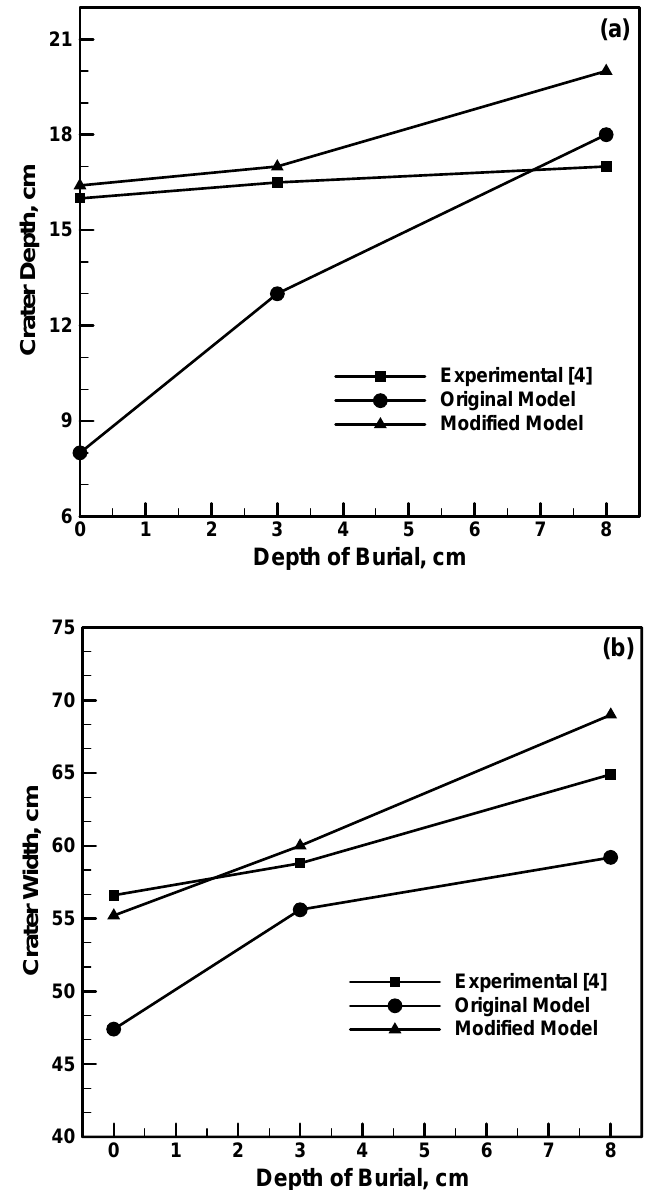
Fig. 10. Variation of the (a) final crated depth and (b) final crater width (at a post detonation time of 12 ms) with depth of burial. Explosive weight and type: 0.1 kg C4; Sand type: − 30/ + 50 mesh silica sand; DOS: 7.5%.